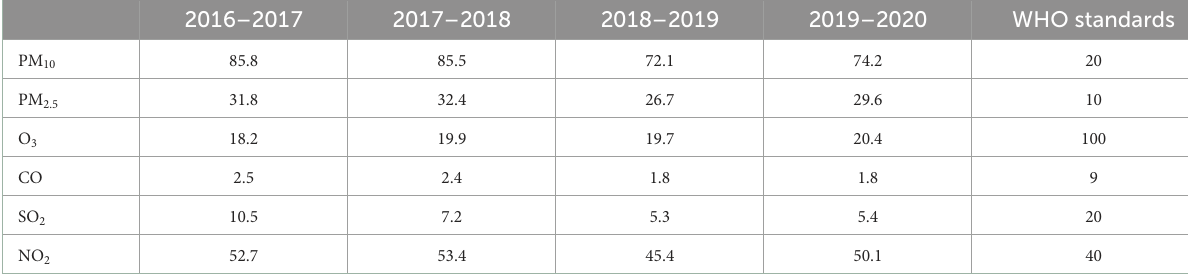
TABLE 1 Comparison of the annual Tehran air pollution during 2016–2020 with WHO